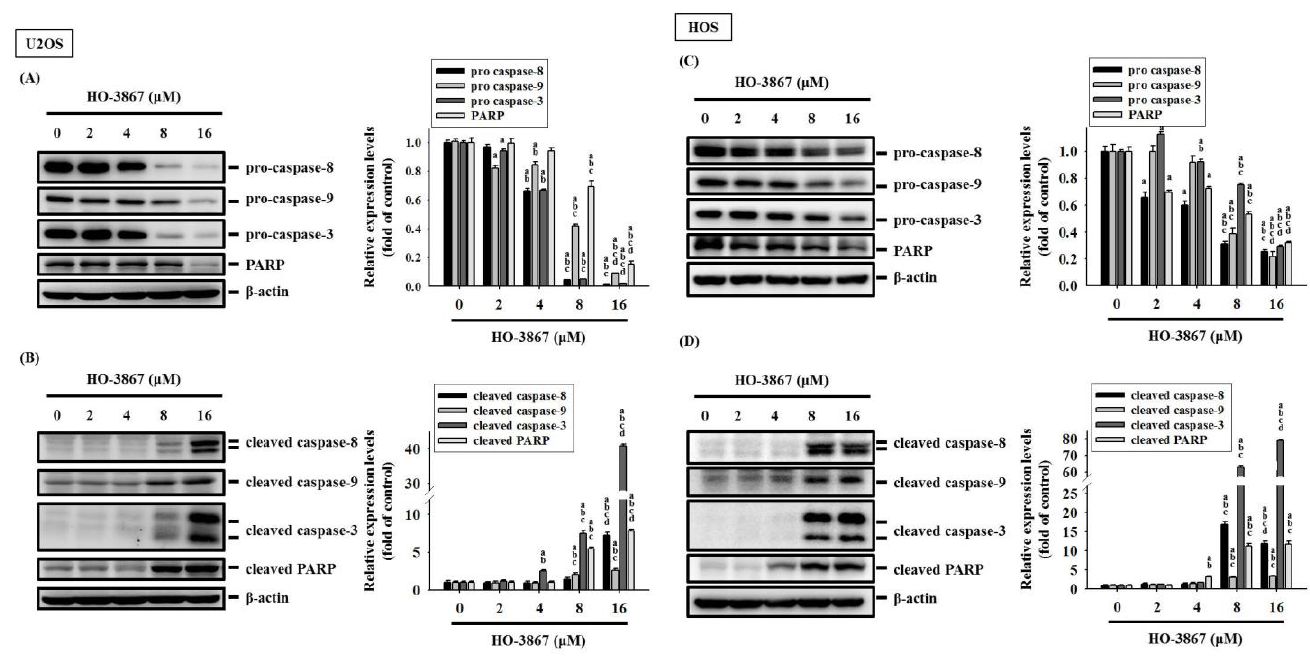
Figure 5. Analysis of activation of caspases 8, 9, and 3 in free and HO-3867-treated U2OS and HOS cells. After experimental concentration range of HO-3867 treatment for 24 h, Western blot analysis was performed to measure expressions of caspases 8, 9, and 3, and PARP as well as their active forms in ( A , B ) U2OS and ( C , D ) HOS cells. Then, quantitative analysis was assessed. n = 3. Caspase 8: U2OS: F = 4689.887, p < 0.001; HOS: F = 310.316, p < 0.001; caspase 9: U2OS: F = 1818.961, p < 0.001; HOS: